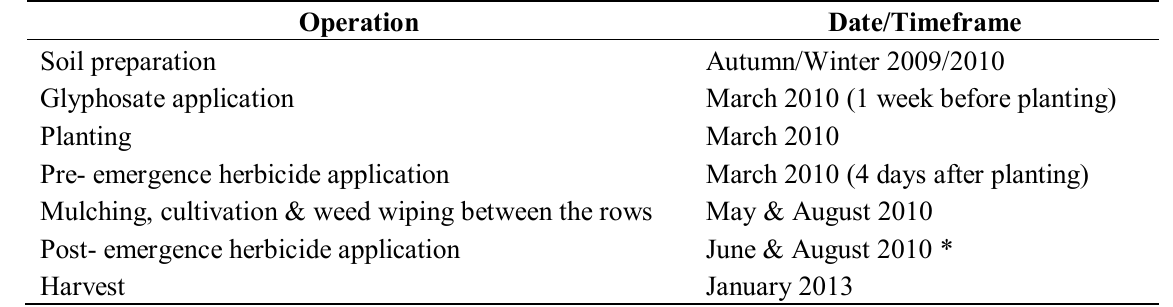
Table 4. Main agronomic practices carried out on